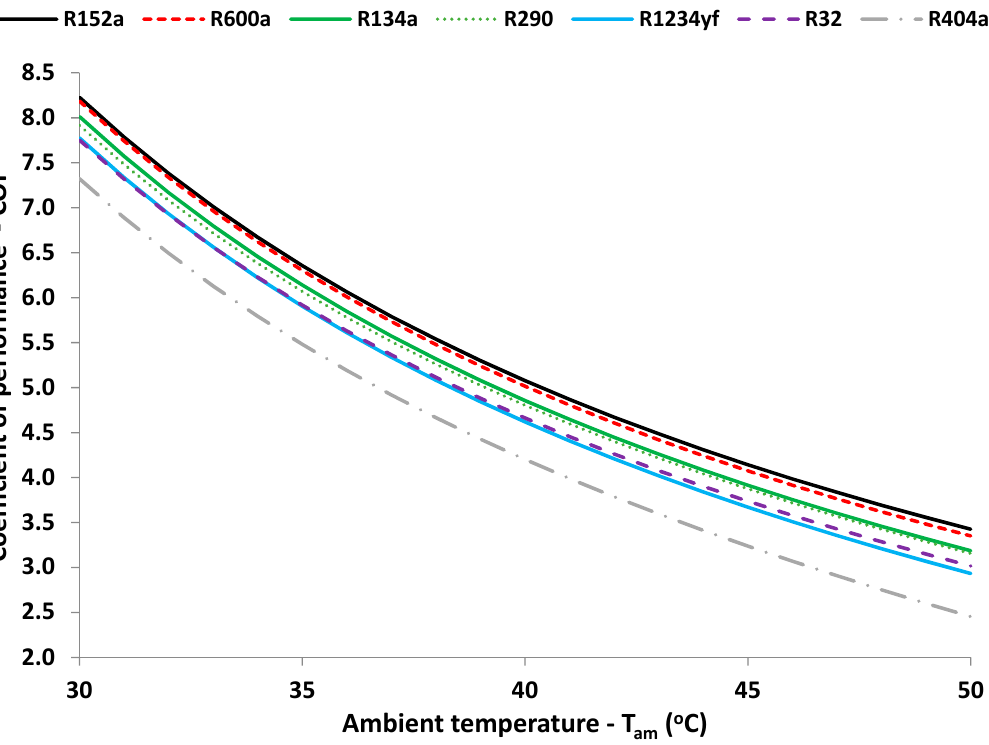
◦ e = 5 kW and T ind = 25